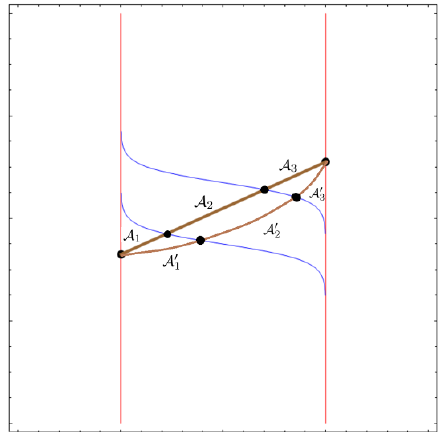
and L v on the boundary. Here A 2 1 2